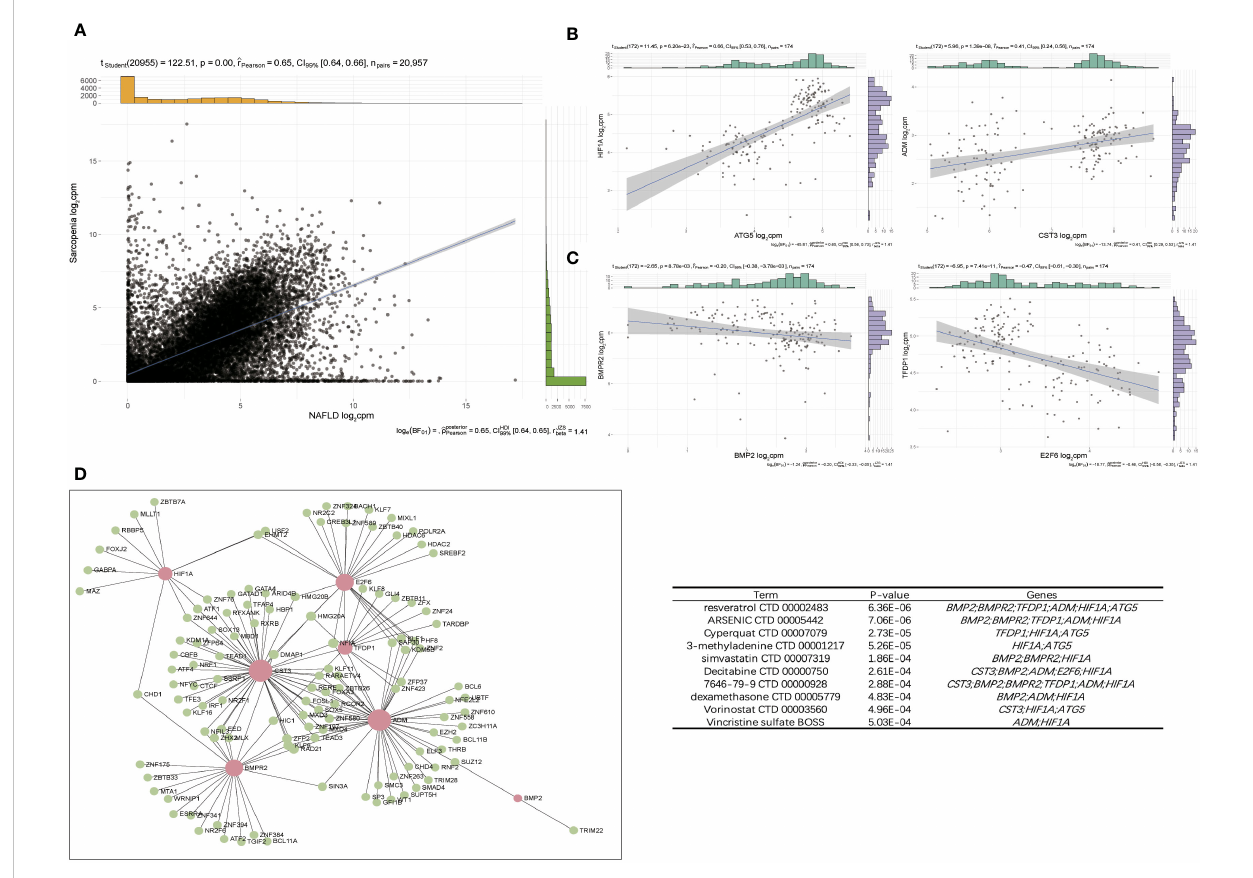
FIGURE 8 Pathway – Gene Functional Network to screen hub gene. (A) Correlation of overlap genes in NAFLD and Sarcopenia. (B) Two pairs of genes that were positive-regulated expressed. (C) Two pairs of genes that were negative-regulated expressed. (D) The TF – target network of periimplantitis. TF, transcription factor.